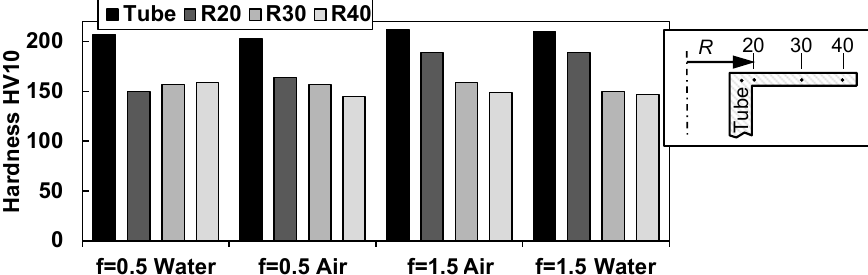
Figure 4. Hardness measurements in the flange core at R = 20, 30 and 40 mm and the tube shaft as a reference. Flange forming by the friction spinning of steel tubes (1.0308) ( D 0 = 40 mm, s 0 = 4 mm). Quenching is performed after the process with water.